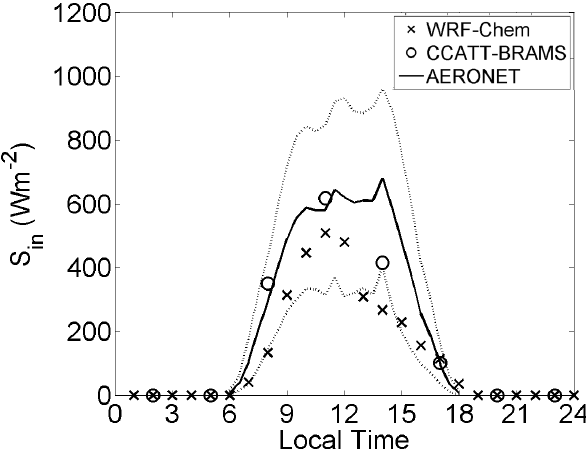
Figure 5. Mean daily cycle of surface incident shortwave radiation from the Manaus AERONET site (solid line, dotted line denotes 1 standard deviation), WRF-Chem (crosses), and CCATT-BRAMS (circles) for the BARCA A period (October–November